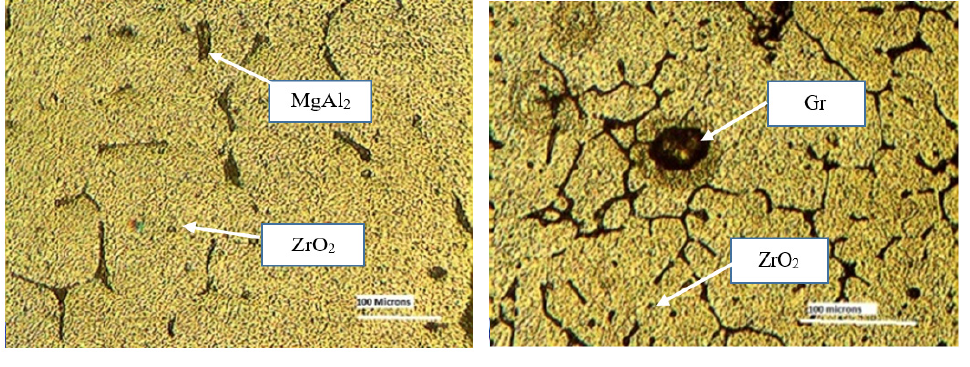
Figure 4. Impact test specimen.